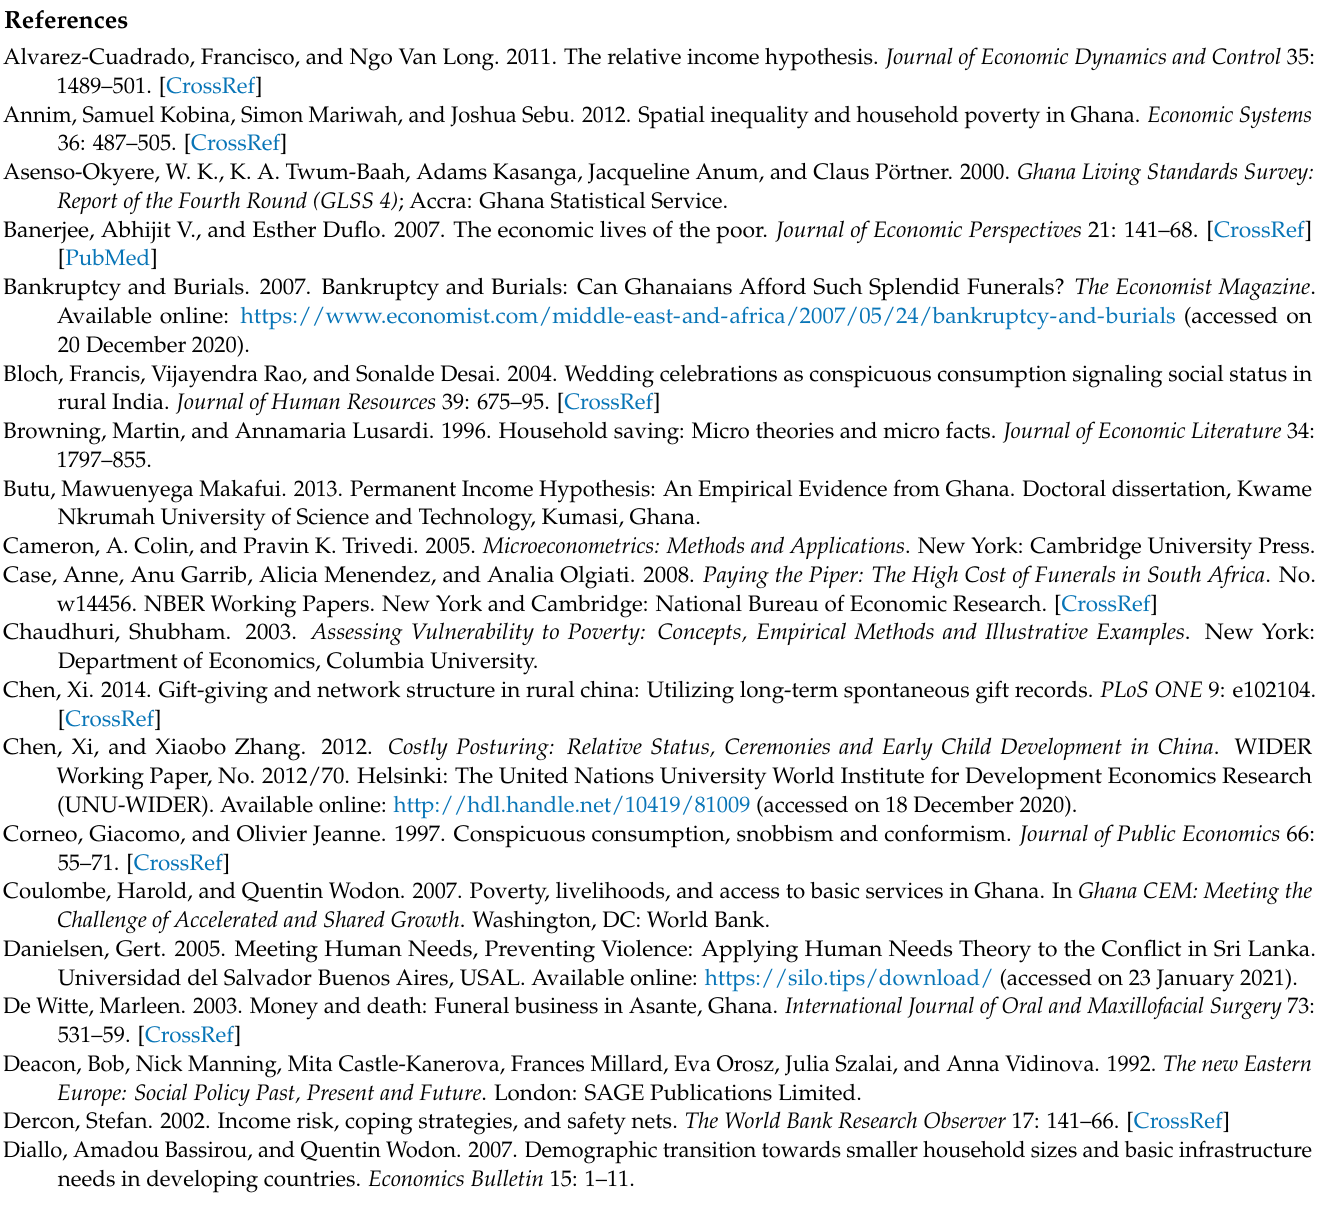
Table S2: Quantile effect of social expenditure on household welfare, 2005/2006 and Table S3: Quantile effect of social expenditure on household welfare,